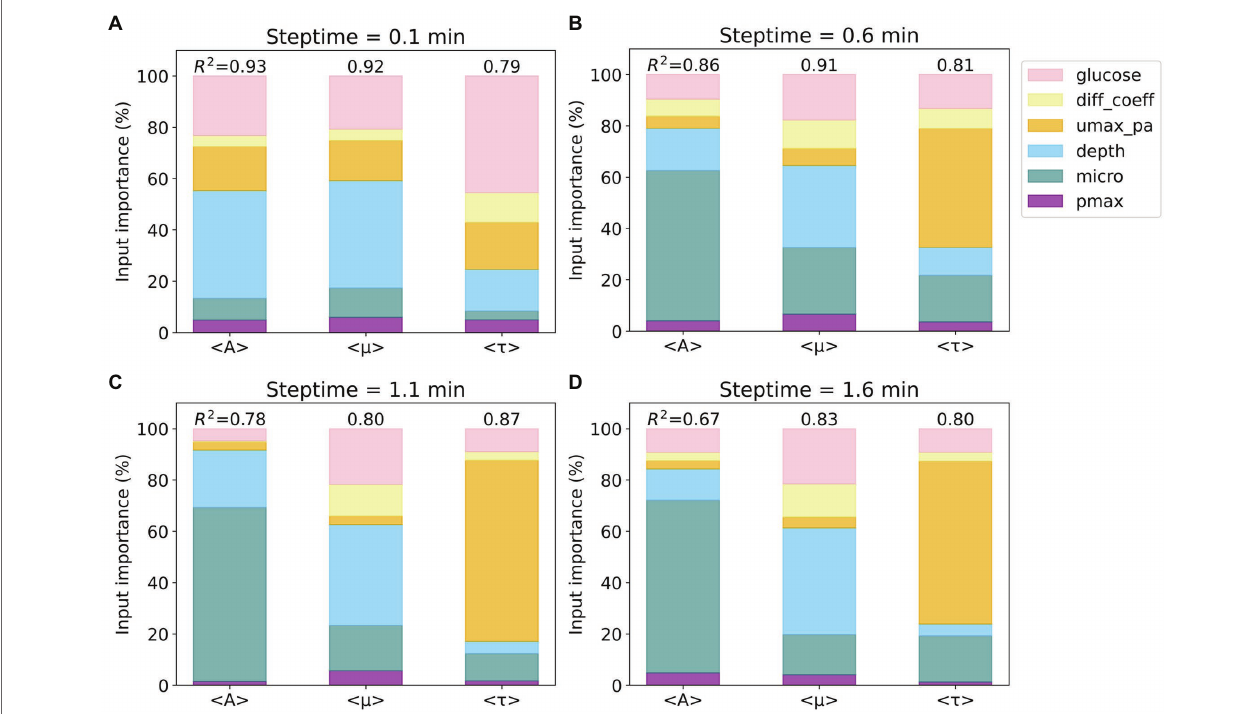
FIGURE 2 | Importance of input parameters to the prediction of average values of A, μ , and τ . Four subsets based on four different steptime values were considered: steptime (A) 0.1, (B) 0.6, (C) 1.1, and (D) 1.6 min. The colors of the six input parameters are shown in the legend. The R 2 scores of the random forest regression models for each subset are included. Note that the importance of the six input parameters sums up to